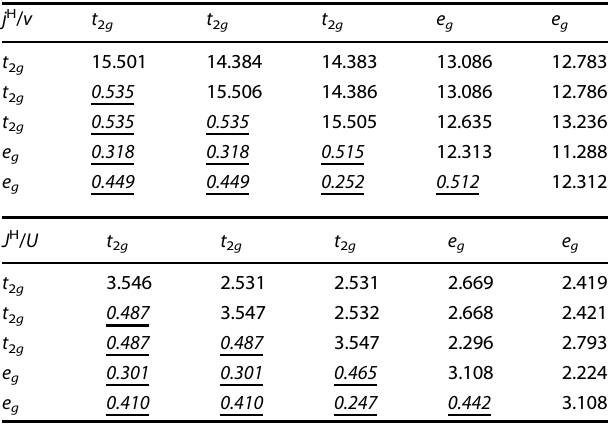
Table 1. Bare ( v / j H ) and cRPA screened ( U / J H ) local Coulomb interaction matrix elements from the d -only basis set in